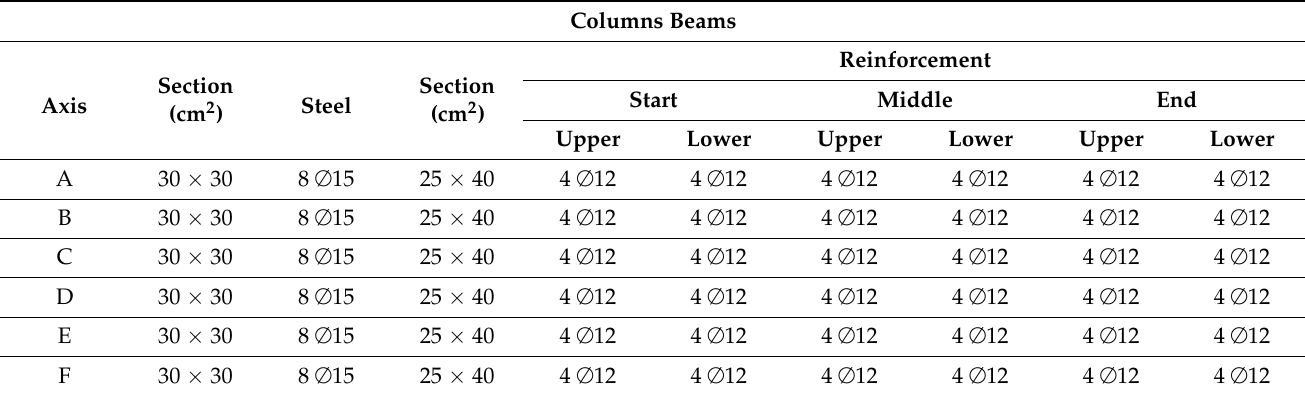
Table 2. Cross-section details for frame.